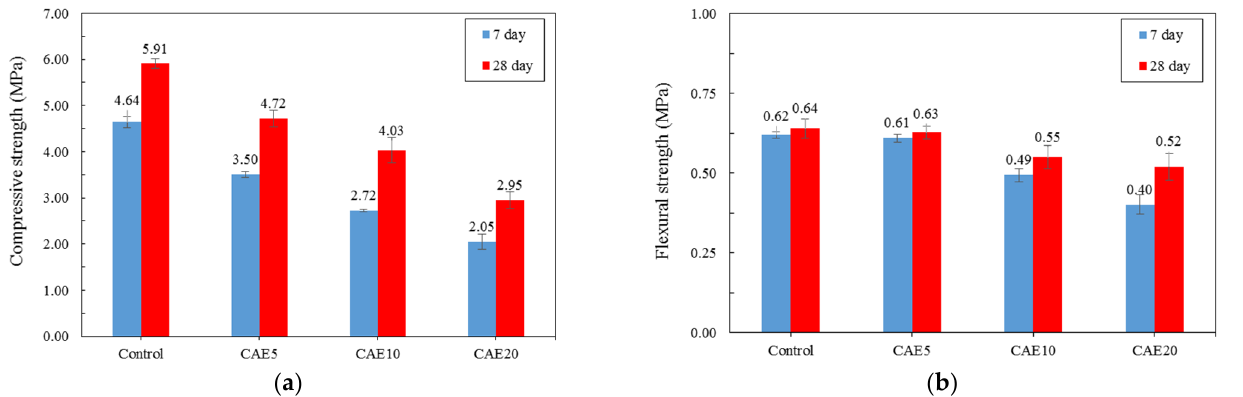
Figure 6. Results for the hybrid alkali-activated mortars with different CAE contents in terms of ( a ) compressive strength and ( b ) flexural strength.